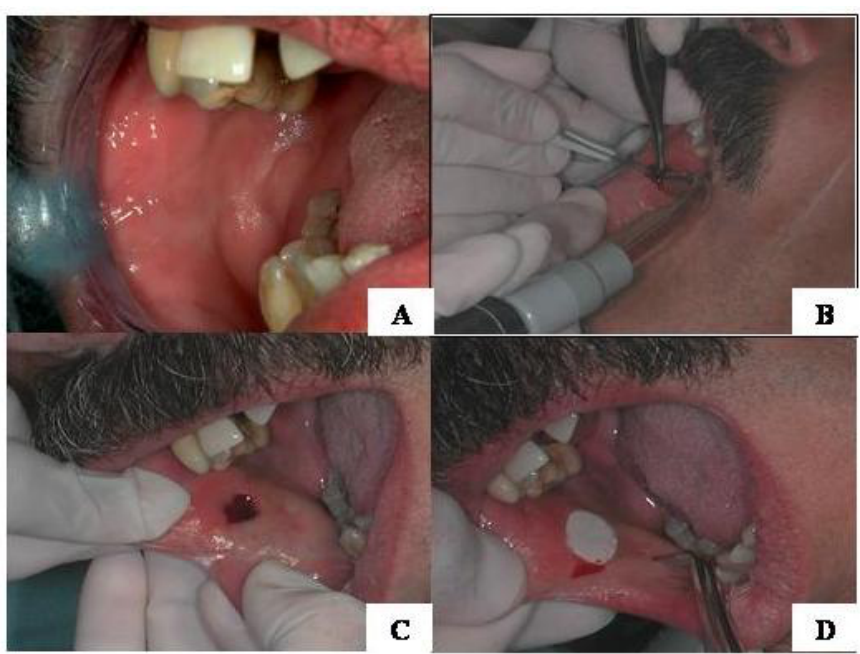
FIGURE 1. Oral mucosa biopsy. (A) The specimens were taken from the mouth at the second molar tooth region beneath the occlusal line. (B,C) The biopsies were performed by incision with cold knife or by punching (6-mm diameter punch biopsy). (D) The suture was obtained via the application of an adhesive containing